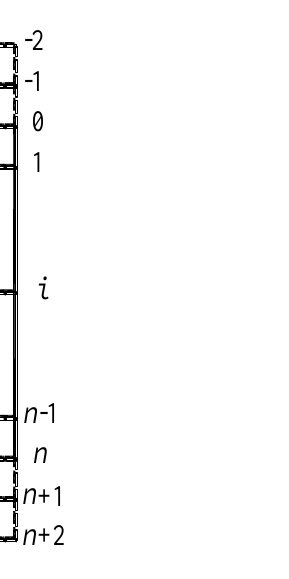
Figure 2. Discrete analysis model of pile.